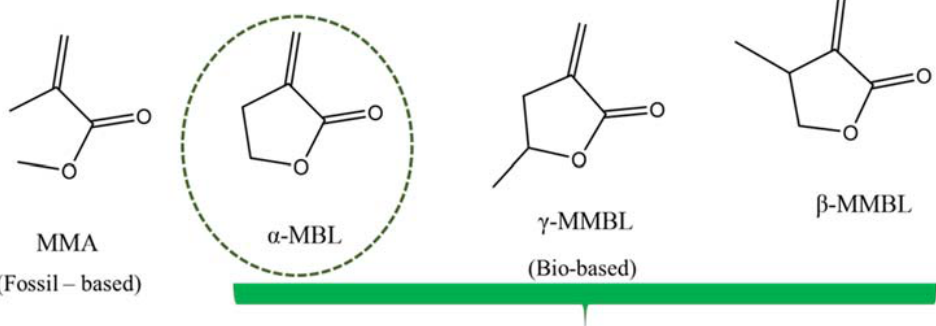
Figure 1. Monomer structures: fossil ‐ based (MMA) and bio ‐ based γ‐ butyrolactone monomers ( α‐ MBL, γ‐ MMBL, and β‐ MMBL).